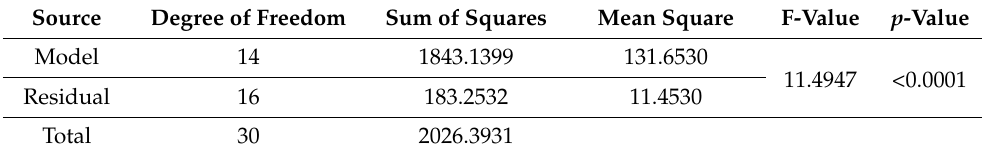
Table 5. Estimated regression coefficients and corresponding F- and p-values for adsorbed PCP.